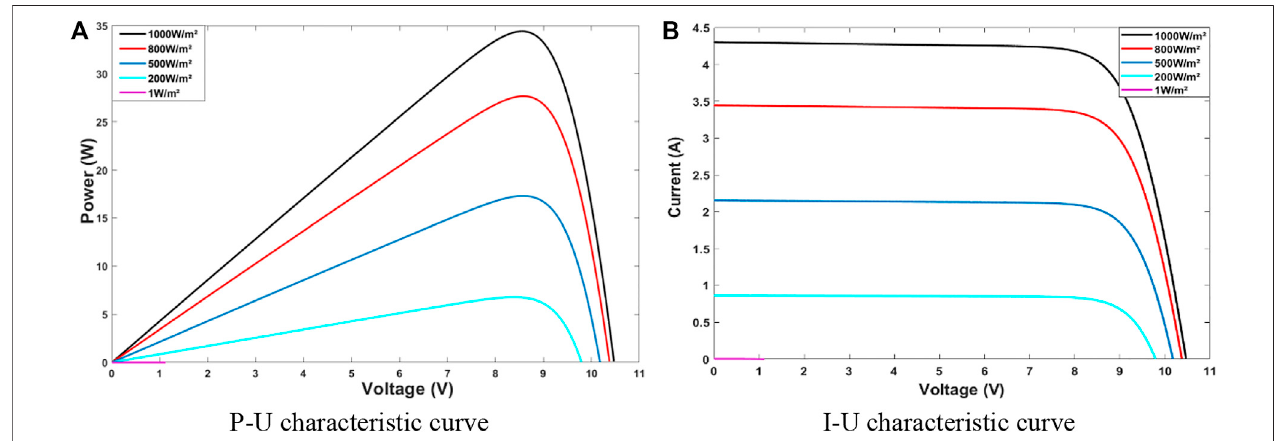
FIGURE 2 | P-U and I-U characteristic curves under the same temperature and different light intensity under uniform conditions.